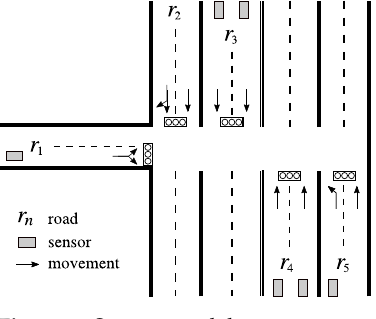
Figure 3. System model.